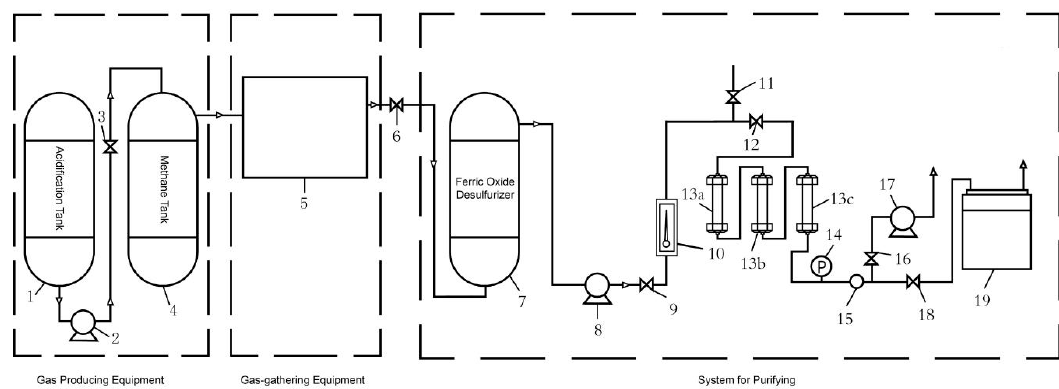
Figure 2. Schematic diagram of biogas production and upgrade setup . 1. acidification tank; 2. pump;